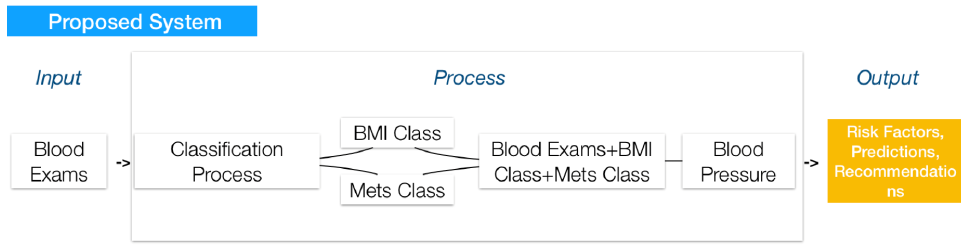
Figure 18. Combination of